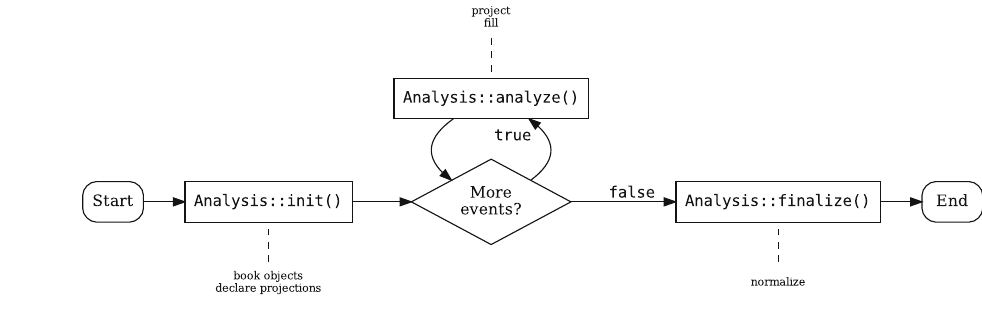
Fig. 2 Execution flow of an Analysis